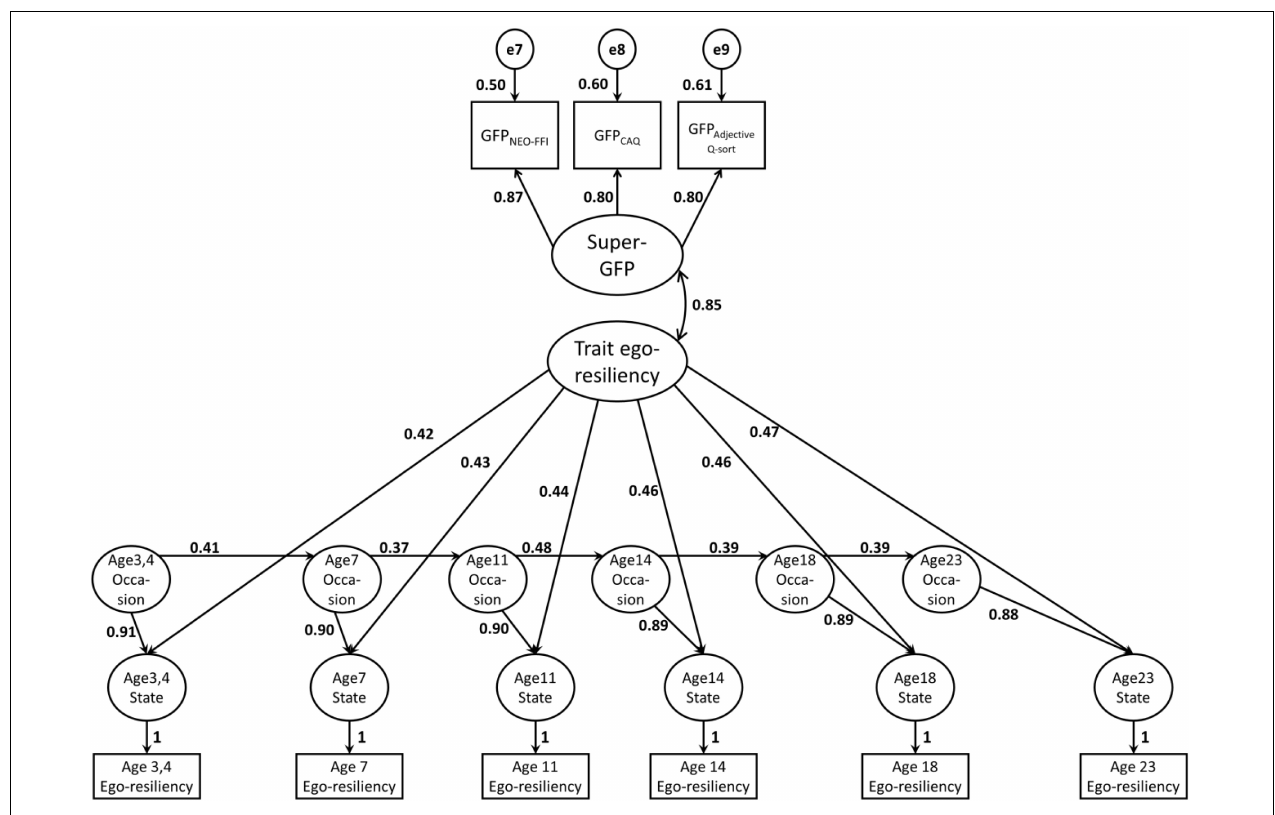
FIGURE 2 | Standardized path estimates for the Trait-State-Occasion